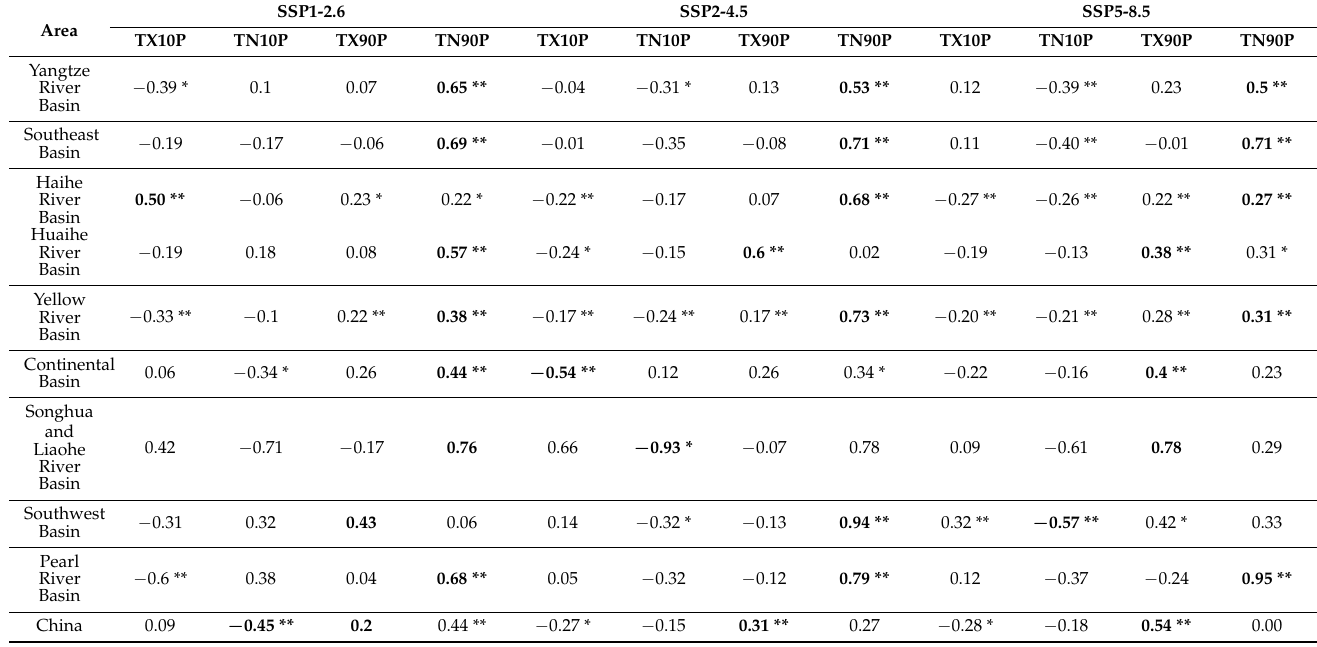
Table 4. Standard regression coefficient between extreme temperature events and T mean in different basins in mainland China from 2021 to 2100 based on